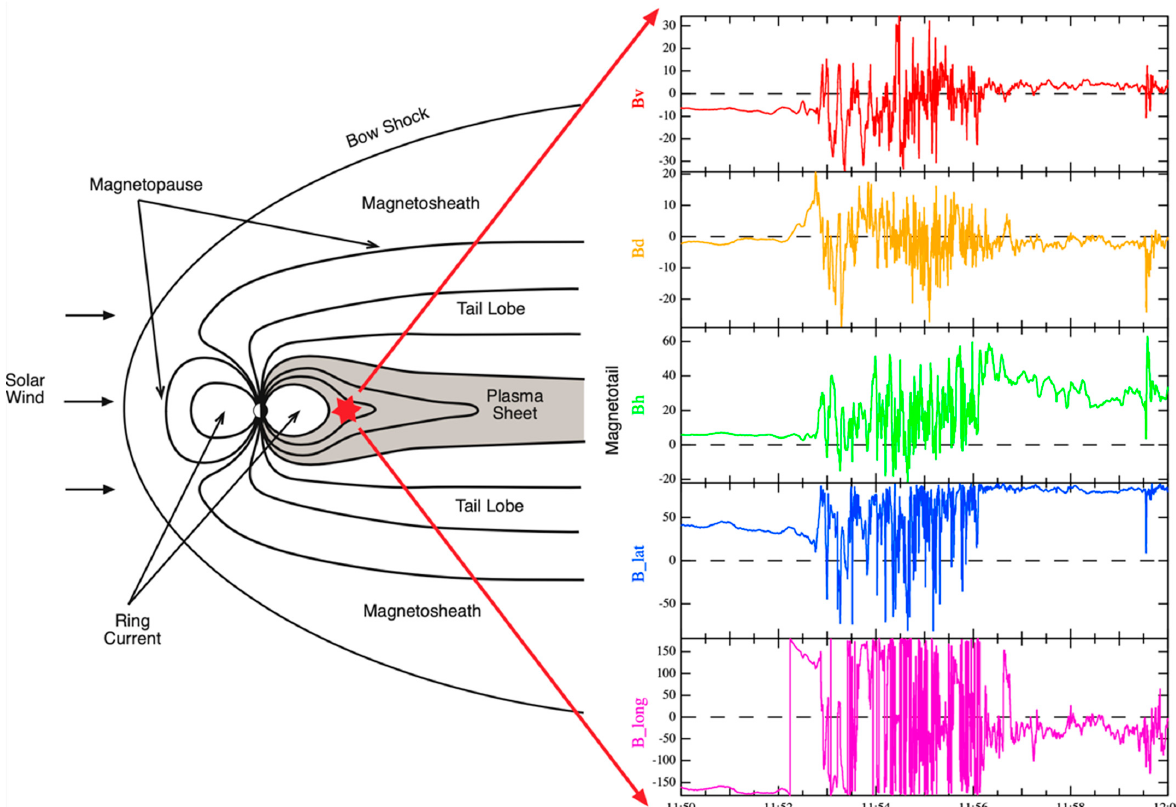
Figure 4. A case of CD is shown to indicate its proximity to Earth in the usually dipolar region (left); the measured rapid fluctuations of the magnetic field components at the site (right). The components of the magnetic field: Bv is the vertical component; Bd is the declination component; Bh is the horizontal component; B_lat is the latitude angle; and B_long is the longitudinal angle.